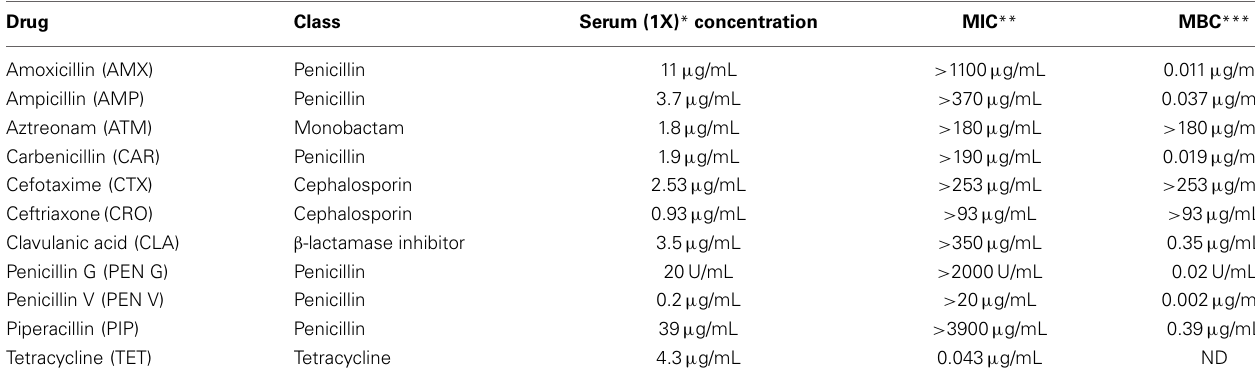
Table 1 | The 1X concentrations, MIC and MBC of all drugs used in this